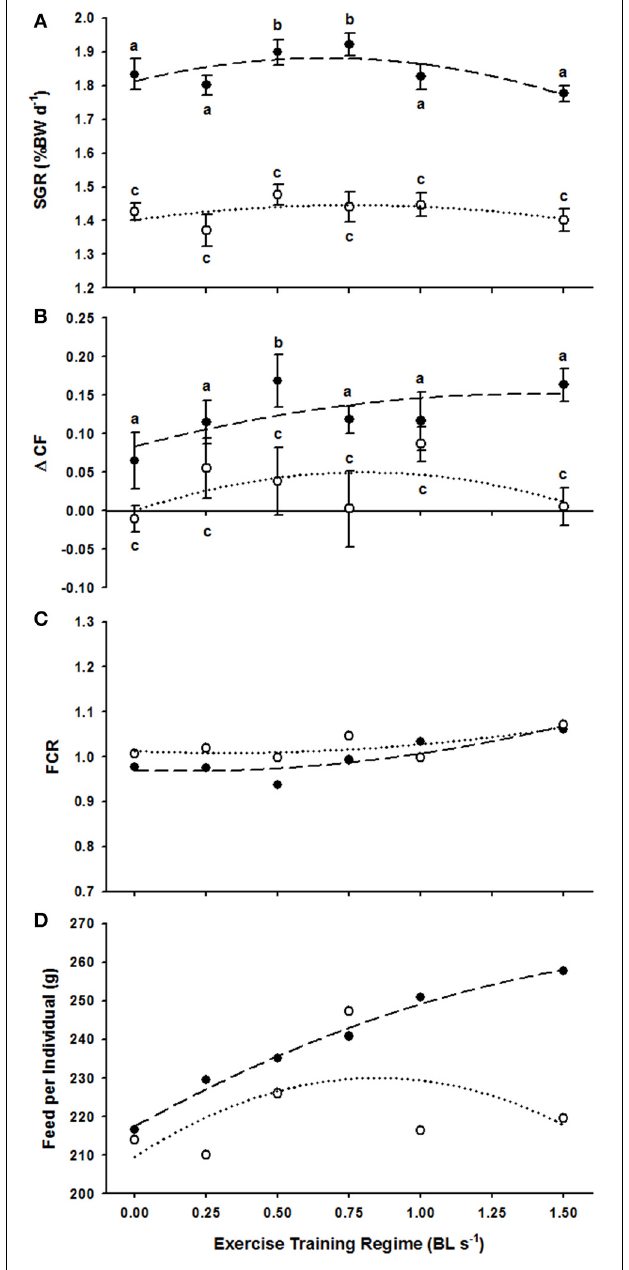
FIGURE 1 | The effect of exercise regimes (ER, in BL s − 1 ) on various production parameters of P. oxygeneios in trial 1 (closed circles, broken line) and trial 2 (open circles, dotted line). (A) Average SGR. Regressions are second order non-linear polynomials described as: y = − 0 . 155 x 2 + 0 . 205 x + 1 . 813 and y = − 0 . 075 x 2 + 0 . 114 x + 1 . 402 for the trial 1 and 2, respectively. (B) Average (cid:2) CF. Regressions are: y = − 0 . 035 x 2 + 0 . 098 x + 0 . 083 and y = − 0 . 078 x 2 + 0 . 125 x for trial 1 and 2, respectively. (C) Feed conversion ratio, FCR. Regressions are: y = 0 . 058 x 2 − 0 . 02 x + 0 . 97 and y = 0 . 0401 x 2 − 0 . 025 x + 1 . 013 for trial and 2 fish, respectively. (D) Feed intake per individual (g). Regressions are y = − 9 . 390 x 2 + 41 . 138 x + 217 . 51 and y = − 28 . 539 x 2 + 48 . 304 x + 209 . 61 for the trial 1 and 2 fish, respectively. Dissimilar letters in each of the plots represent a significant difference between swim speed treatments ( P < 0 .